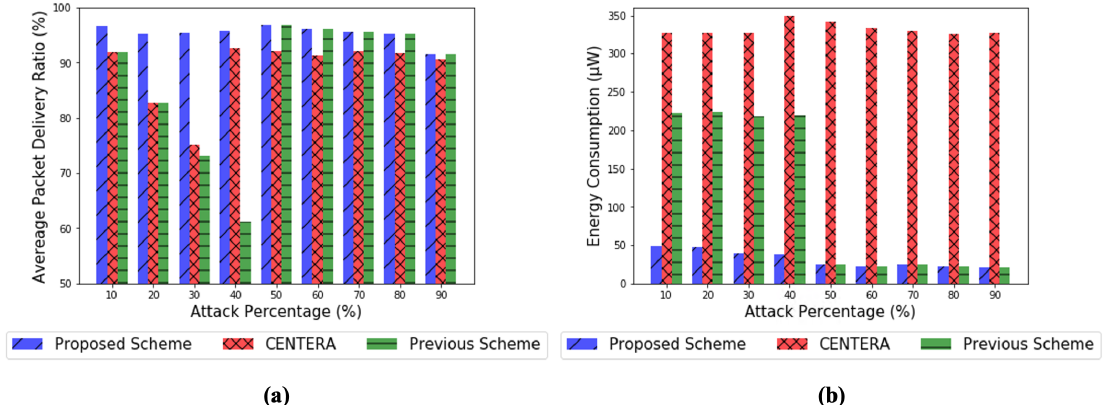
Figure 9. ( a ) Packet delivery ratio and ( b ) energy consumption in the case of gray-hole attack by varying attack